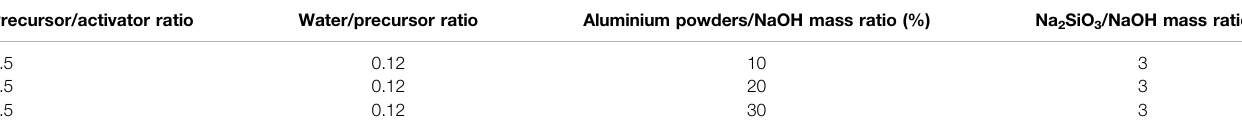
TABLE 1 | The mix design of foamed alkali-activated glass samples.